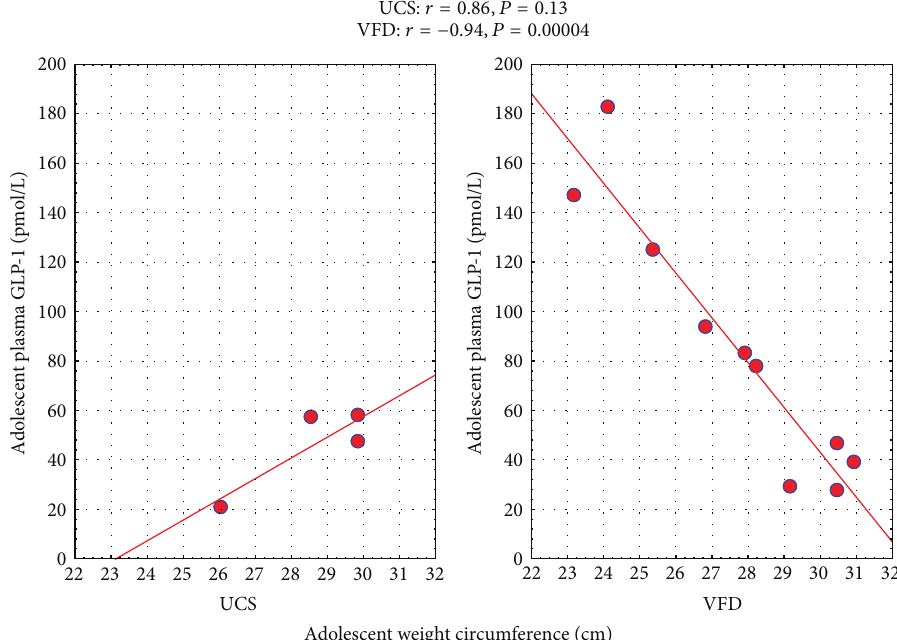
Figure 3: Relationship of adolescent pGLP-1 to adolescent waist circumference as a function of early life stress. For abdominal circumference (cm), a markedly inverse correlation with pGLP-1 was noted in VFD subjects but the same correlation in non-VFD subjects was nonsignificantlypositive,leadingtoasignificant“ 𝑟 ”differencebetweenrearinggroups.GLMrevealedasignificantrearinggroup ∗ abdominal circumference interaction in the prediction of pGLP-1 [ 𝐹 (1,10) = 20.11 ; 𝑃 = 0.0012 ]. When adjusting for abdominal circumference, pGLP-1 concentrations (pmol/L) were significantly increased in VFD versus non-VFD subjects [VFD mean (SE) = 85.00 (5.45) versus non-VFD mean (SE) = 45.68 (8.61); 𝐹(1,10) = 21.43 ; 𝑃 = 0.0009 ].